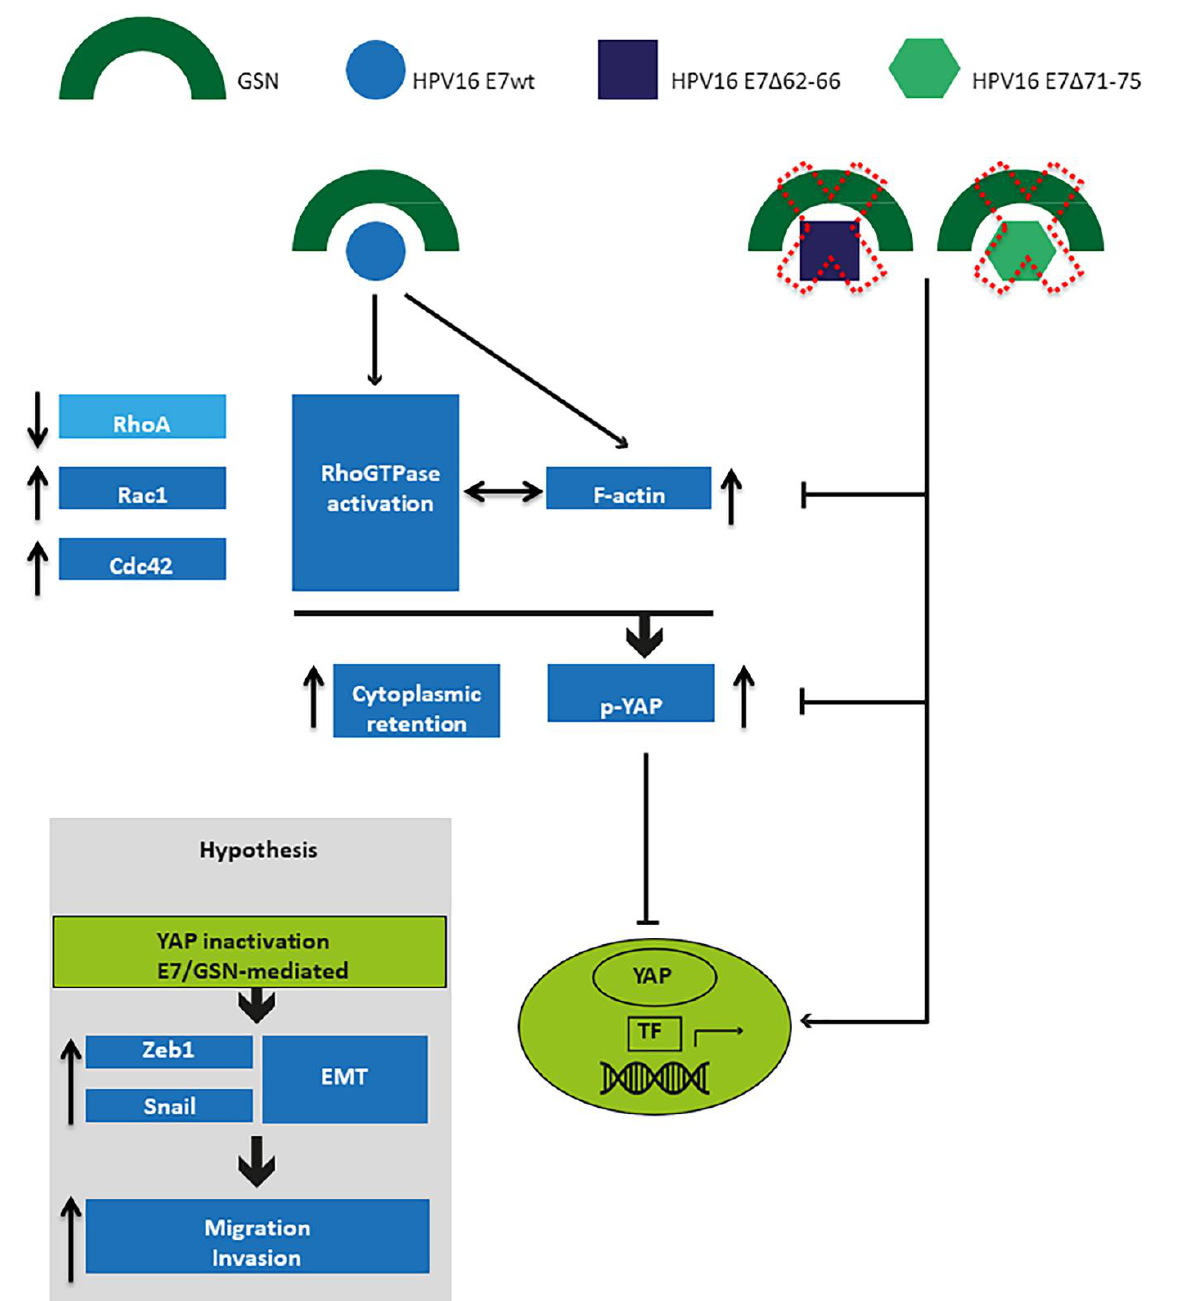
Figure 7. Cartoon illustrating the potential cascade of events due to the physical interaction of E7wt with GSN. In this model, we suggest a crucial role of the molecular association of E7wt with GSN in HPV-positive tumor cell motility and aggressiveness. In this process, the activation of Rac1 and Cdc42 and the increase of polymerization state of actin would be decisive in inducing EMT-related morpho-functional alterations via YAP signaling.